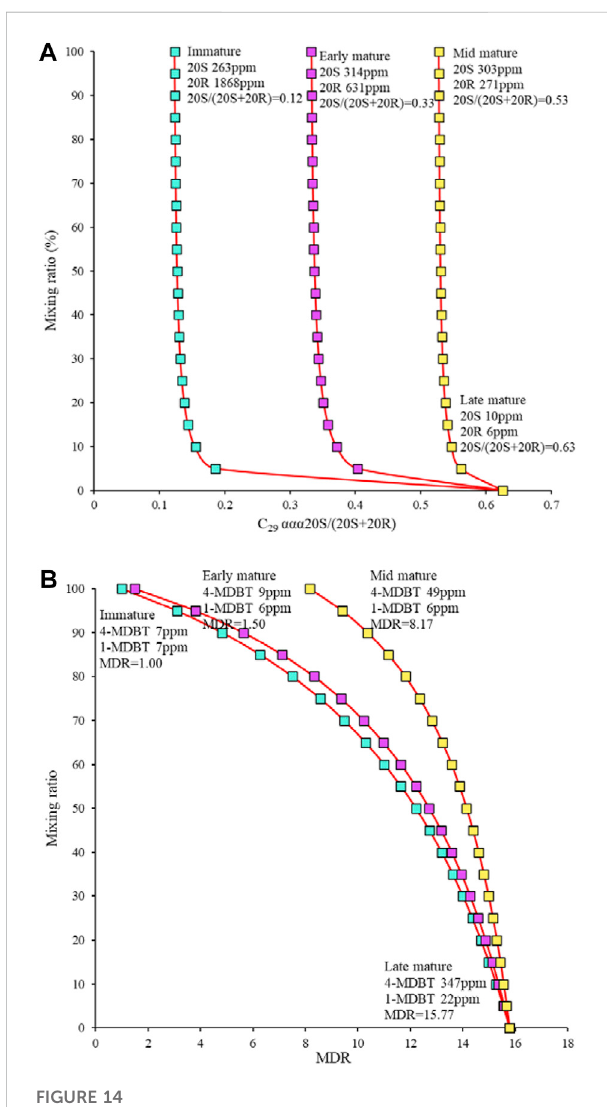
FIGURE 14 VariationsofC 29 αααα 20S/(20S+20R) (A) andMDR (B) ratiosafter mixing with different maturity crude